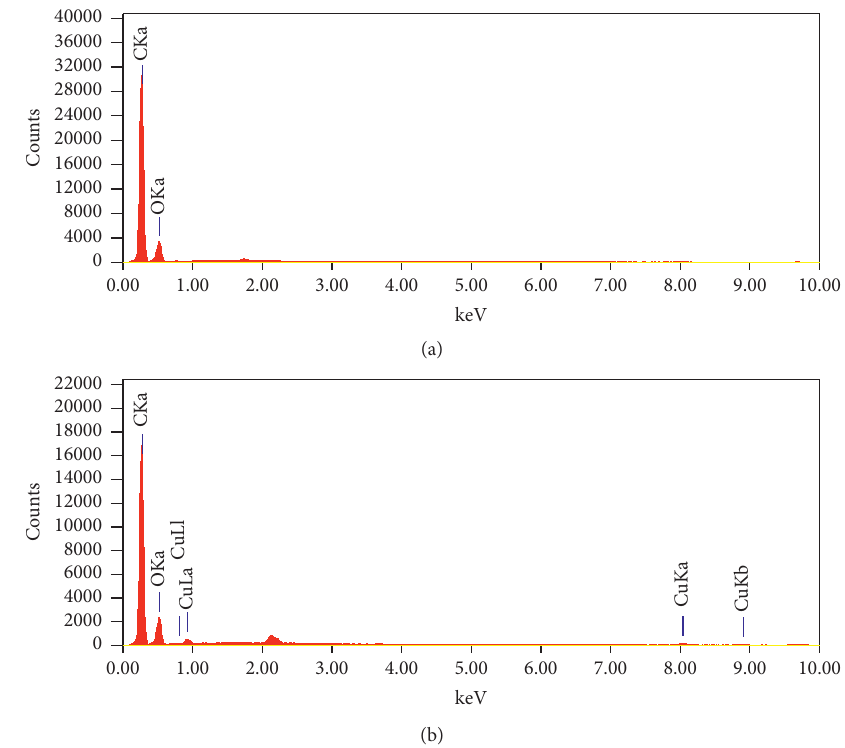
Figure 5: EDAX analysis of the bare organic monolithic rod (a) and CuBTC-monopol monolith (b).